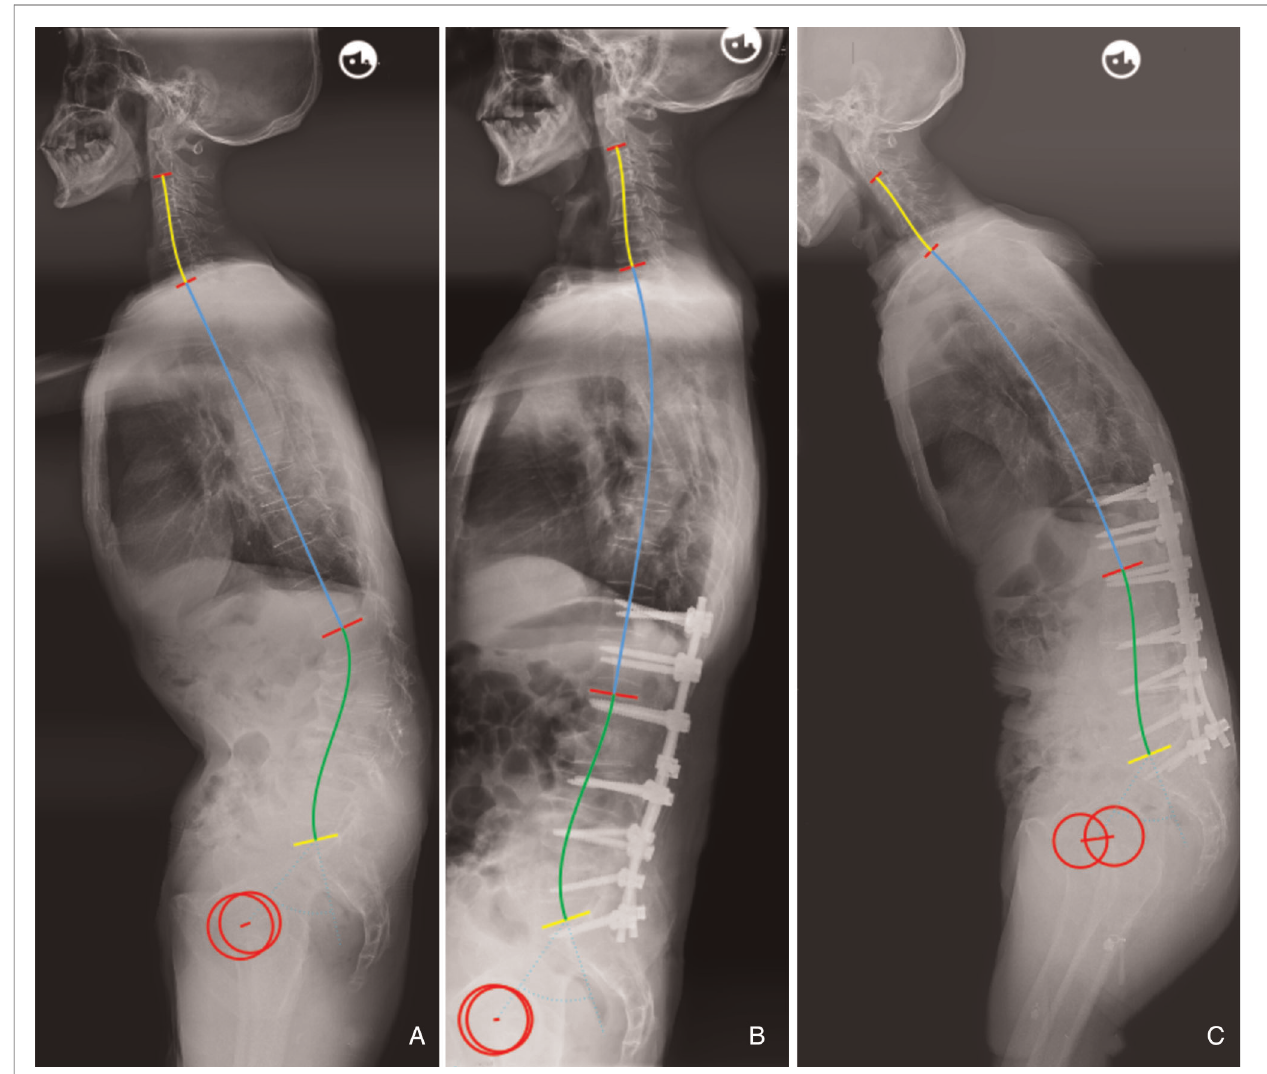
FIGURE 6 | 65-year-old male ( A ) preoperative sagittal standing full spine X-rays, pelvic incidence (PI)=53.6°, thoracic kyphosis (TK)=2.4°, lumbar lordosis (LL)= 11.5°. ( B ) immediate postoperative X-rays, PI=53.3°, TK=15.5°, LL= − 26.3°; ideal LL=0.7*53.3+0.4*15.5+1= − 44.5°, Δ LL=26.3 – 44.5=18.2°. ( C ) Distal screw pull-out at 2.5-year